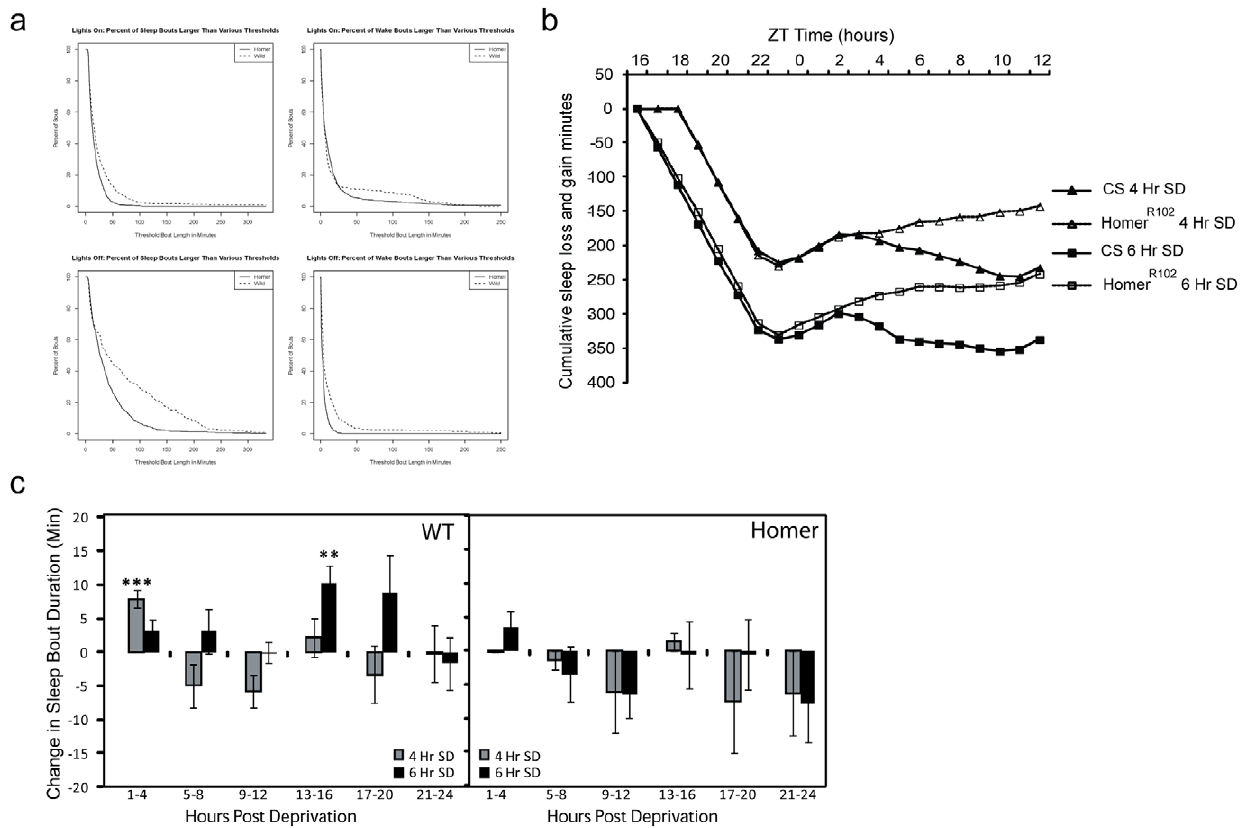
Figure 2. The response to sleep deprivation is altered in Homer null flies. A) Distribution of sleep and wake bouts during the lights on (top panels) and lights off (bottom panels) periods in Homer R102 and wildtype flies. Sleep was assessed using 5 second epochs. Both sleep and wake bouts are shorter in the Homer mutant flies. The most striking difference occurs during the night where the average sleep bouts are much shorter in the homer mutant flies than in the background strain. B) Recovery sleep profile following 4 and 6 hr SD in homer R102 and CS flies. Plot illustrates the cumulative sleep loss and gain over 12 hours following sleep deprivation. Rebound recovery sleep lasts longer in homer R102 than in wildtype flies. C) Effect of sleep deprivation upon sleep bout duration. Panel A: wildtype flies: the average delta in bout duration 6 standard deviation post sleep deprivation is shown for 4 and 6 hour SD. Sleep bout duration lengthens after SD for wildtype flies deprived for 4 and 6 hours. Panel B: Homer null flies do not show any lengthening of sleep bouts when sleep deprived for 4 or 6 hours. Bout duration changes which are significantly different from baseline are designated as follows: * , 0.05 . 0.01; ** , 0.01 . 0.001, *** , 0.001.